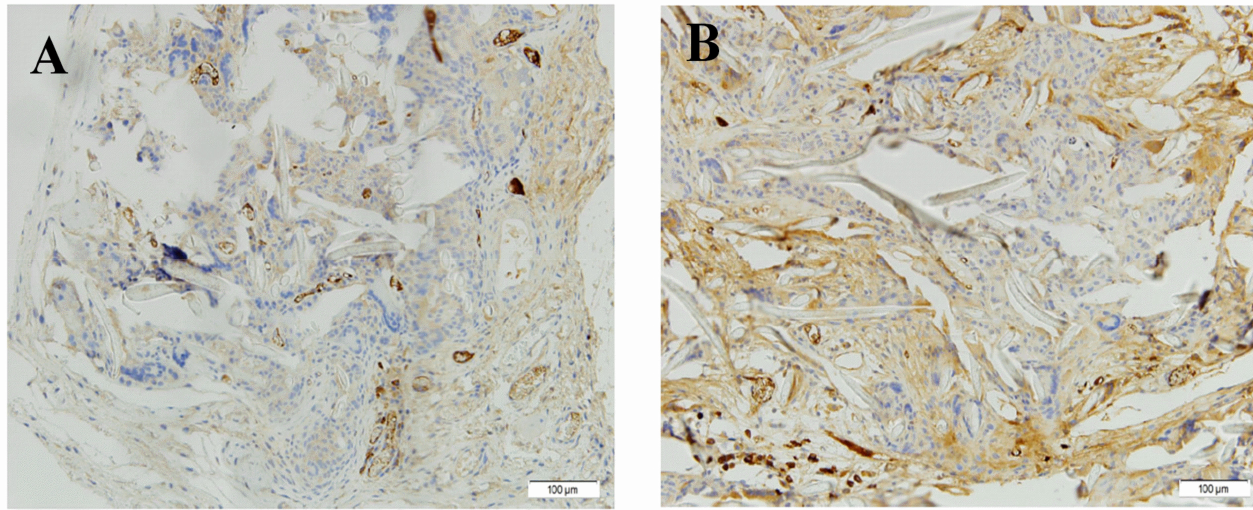
Figure 5. SMA antibody immunohistochemistry (magnification of 20 × ) of the ( A ) static and ( B ) dynamic PCL/elastin scaffolds seeded with